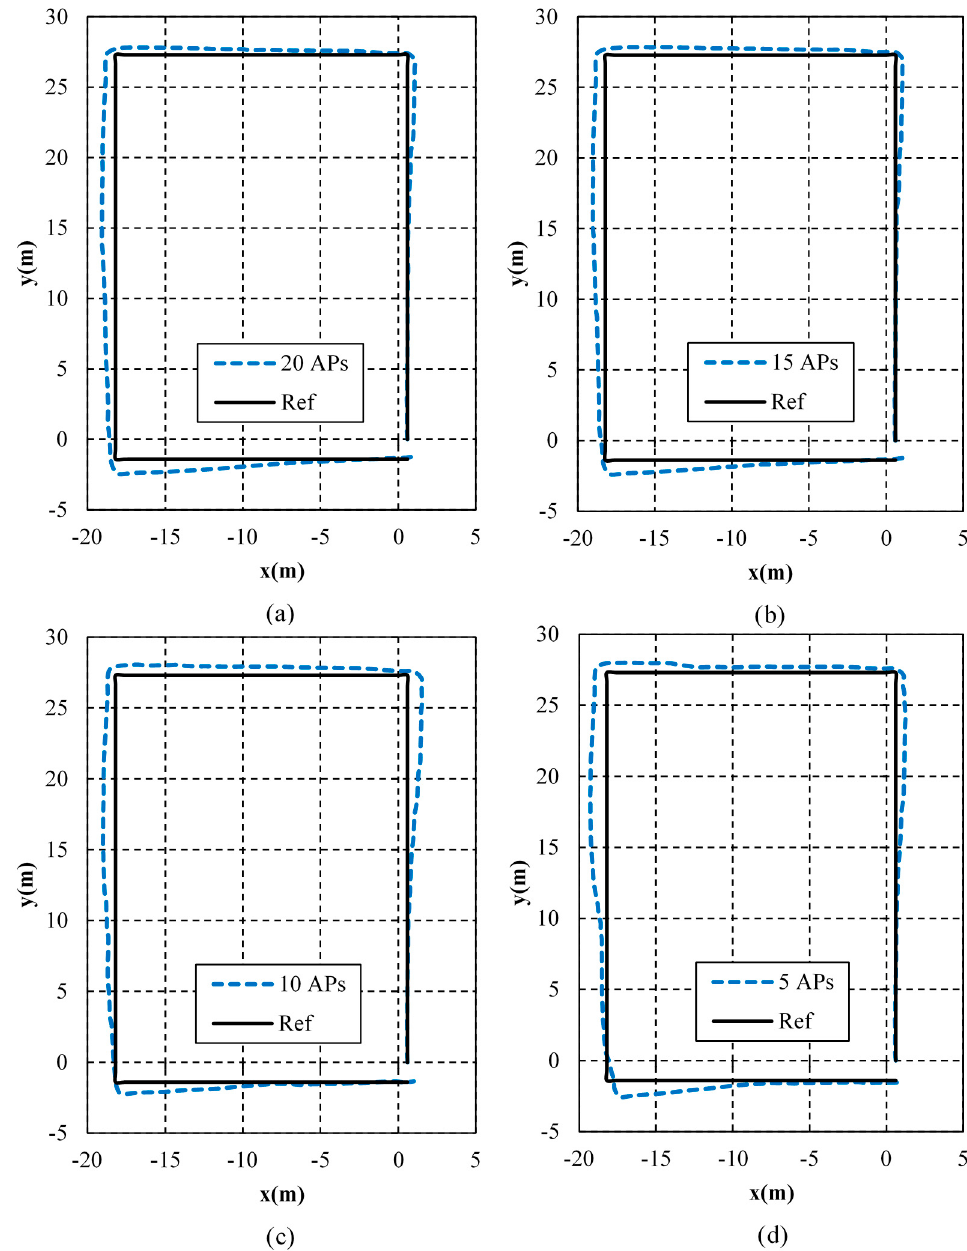
Figure 12. Positioning results using different numbers of APs. ( a ) 20 APs; ( b ) 15 APs; ( c ) 10 APs; ( d ) 5 APs. Table 5. Positioning errors using different numbers of APs.